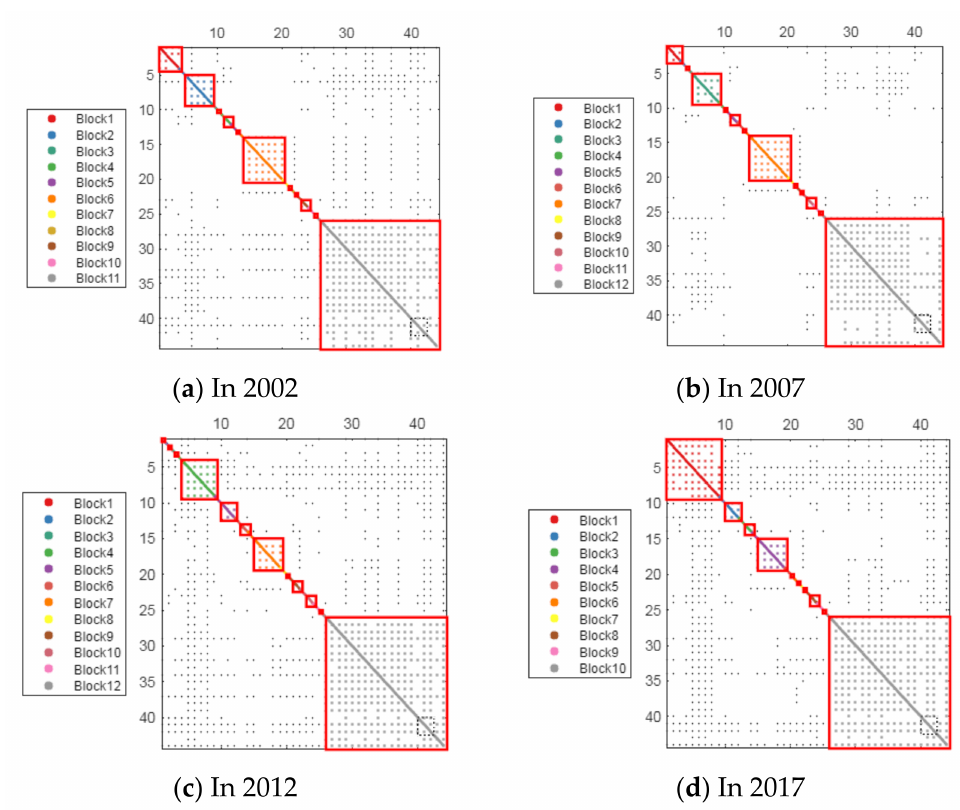
Figure A2. The estimated covariance matrix that obtained by APL-HCG in 2002, 2007, 2012, and 2017. Each solid dot in sub-figures represents the estimated covariance of linkages between the sectors corresponding to the row and column position is not zero. Each red rectangle marks a sector group, and the estimated covariance of the linkages among most sectors within the group is not zero. We use solid dots of different colors to indicate different sector